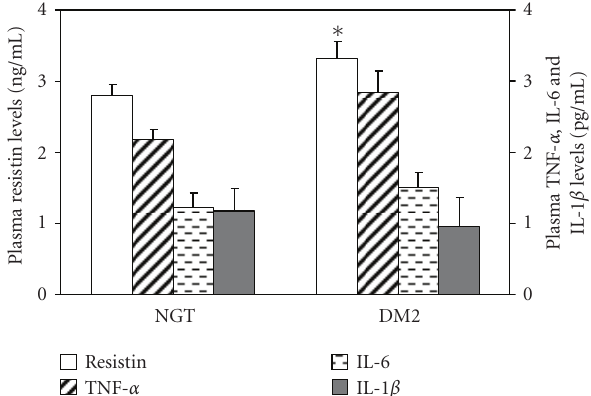
Figure 2: Comparison of circulating resistin, TNF- α , IL-6, and IL-1 β protein levels between the NGT-healthy control and DM2 women. ∗ P < . 051 versus